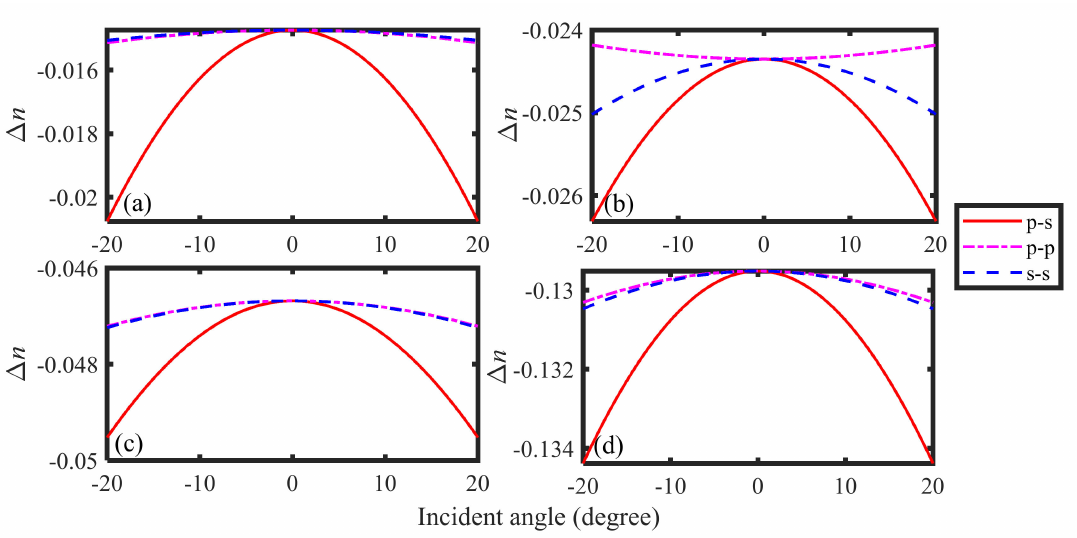
Figure 8. The angular dependence of the refractive indices difference ∆ n . ( a ) BBO; ( b ) KDP; ( c ) LiNbO 3 ; ( d ) Ag 3 AsS 3 . The red solid lines, pink dotted lines, and blue dotted lines in each subplot represent the p-s polarization, p-p polarization, and the s-s polarization,